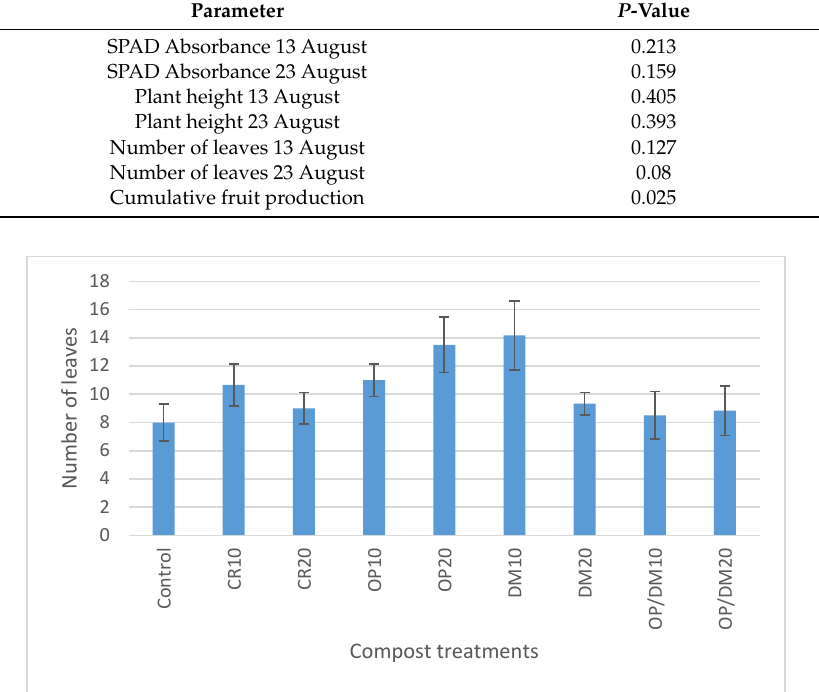
Figure 9. Number of leaves of bell pepper plants as affected by different compost sources and rates. Error bars represent ± standard error ( P = 0.08, n = 6).